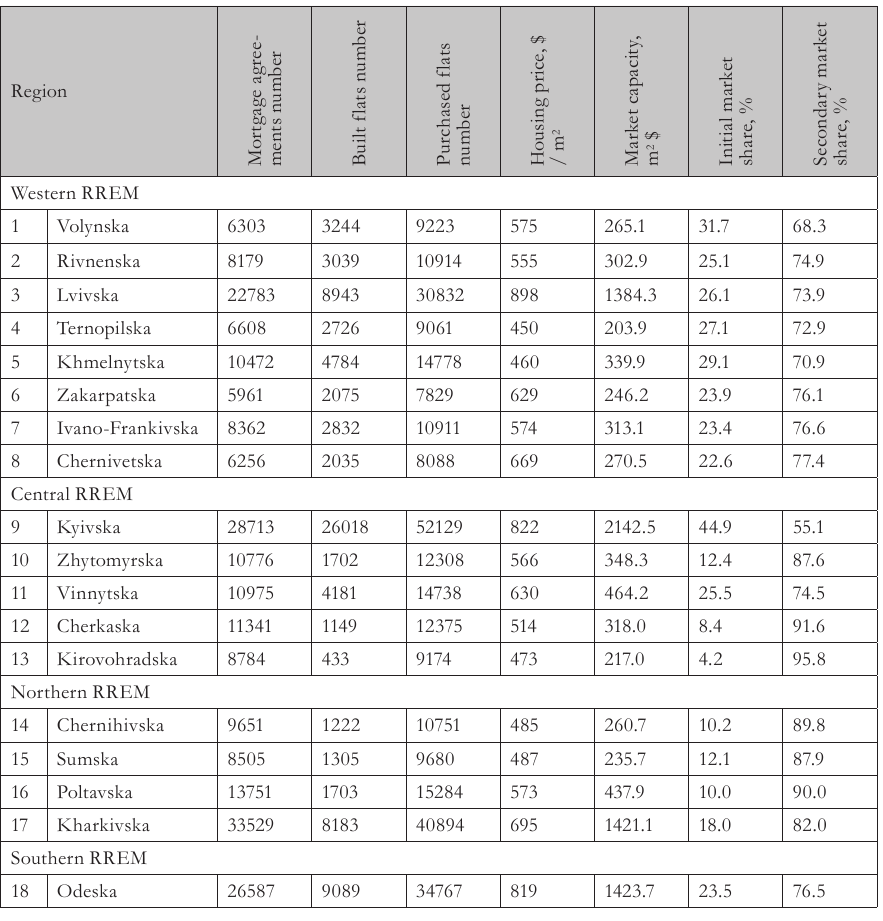
Tab. 2 – The capacity of the housing market in Ukraine regions in terms of their division into RREM, on January 1, 2017, (excluding the temporarily occupied territory of the Autonomous Republic of Crimea, the city of Sevastopol and parts of the zone of the anti-terrorist operation in Donetska and Luhanska regions). Source: Ministry of Justice of Ukraine